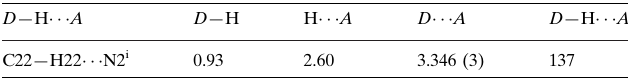
Hydrogen-bond geometry (A˚ , (cid:4)